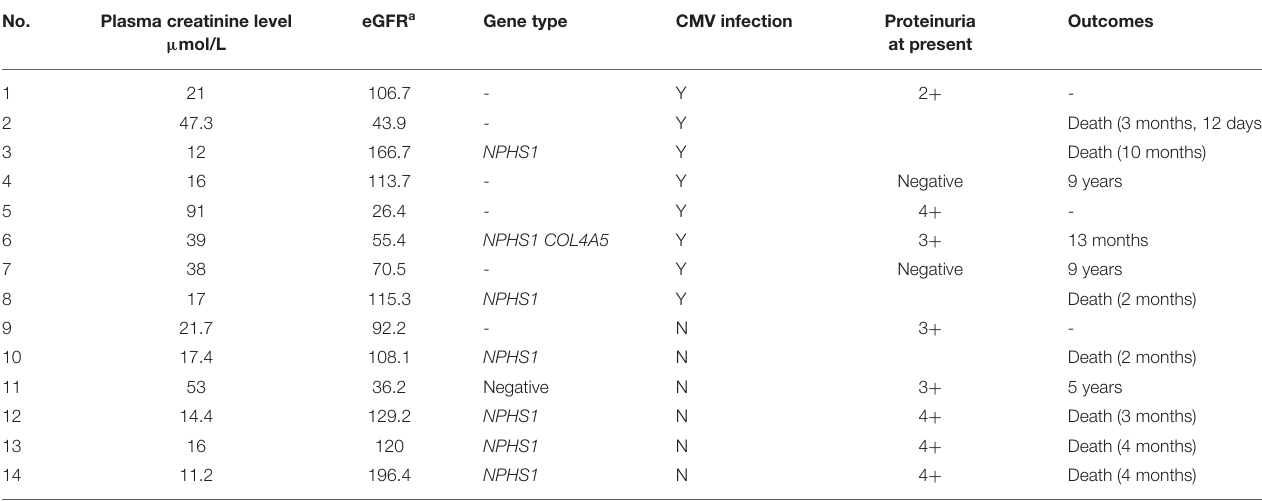
TABLE 2 | Clinical features of 14 patients. No. Plasma creatinine level eGFR a Gene type CMV infection Proteinuria µ mol/L